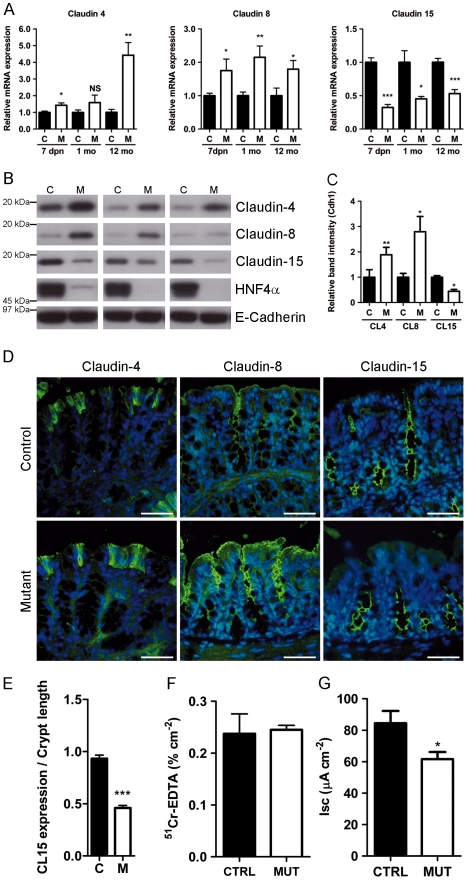
Claudin-15 and ion transport are modulated in Hnf4α colon null mutants.(A) qRT-PCR of claudin-4, -8 and -15 at various time points in mutants (Open bars) relative to controls (Black bars). Expression levels are shown as mean values (± SEM) relative to controls at each time point (3–14 mice per group) and were normalized with the Tbp housekeeping gene. (B) Immunoblotting confirmed modulated protein levels of claudin-4, -8 and -15 at 12 months in mutants (n = 3, open bars) and relative controls (n = 3, black bars) normalized to stable expression of E-Cadherin (Cdh1). (C) Quantification of band intensities of each claudin (means ± SEM; n = 3 or 4 for each group) relative to Cdh1. (D) Indirect immunofluorescence (FITC) of claudin-4, -8 and -15 in 3 month-old animals in proximal colon (representative of 4 pairs). Nuclei were counterstained with DAPI (blue) and merged with FITC (green). Scale bars, 50 µm. (E) Claudin-15 expression is lost in the upper half of the colon epithelium in mutants (Open bar) relative to controls (Black bar). (F) Colonic permeability to 51Cr-EDTA measured in colon tissues from 2 month-old mice (5 mice per group). (G) Baseline short circuit current (Isc) measured in colon tissues from 2 month-old mice (5 mice per group). Represented as mean values ± SEM, * P≤.05, ** P≤.01, *** P≤.001.